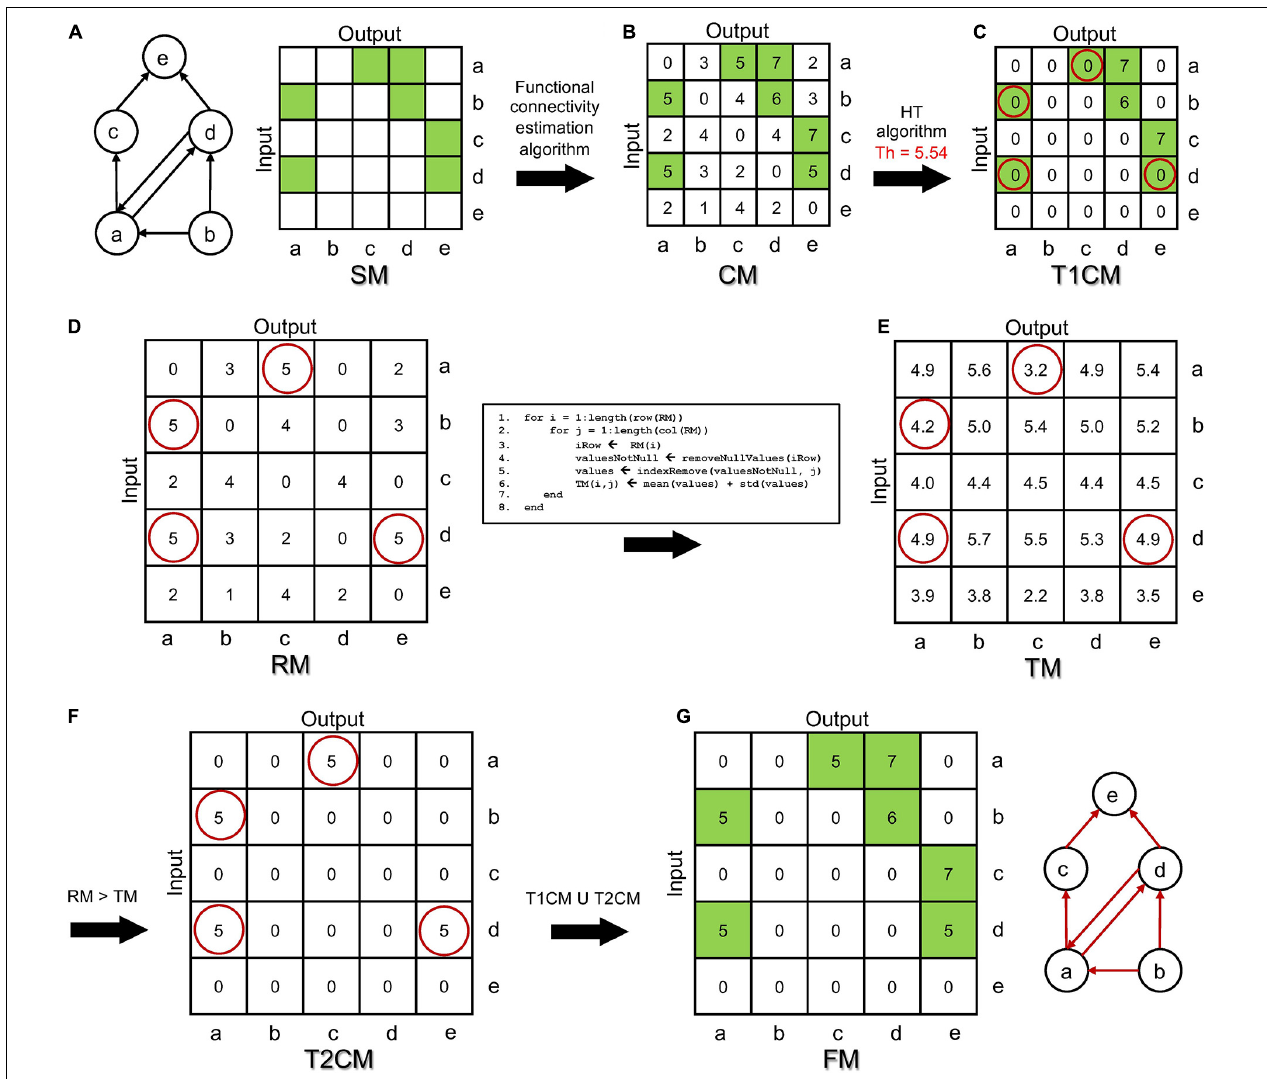
FIGURE 1 | Double Threshold (DDT) algorithm operating principle applied to a simple network. (A) Structural graph made up of n = 5 nodes and the k = 7 structural directed links (left). Structural connectivity matrix (SM) where each green square identifies a structural connection in the graph (right). (B) Functional connectivity matrix (CM) obtained by applying the correlation algorithm to each pair of spike train. In the CM, the green squares show the functional connectivity values that correspond to the actually existing structural links in the network. (C) Applying the first hard threshold ( n = 1), the T1CM matrix was computed. In T1CM, the red circles point to those connections incorrectly deleted from the CM (false negatives). (D) The rejected connectivity matrix (RM) is made of all the values that have been previously deleted by applying the hard threshold to the CM. By applying the stripping process summarized in the pseudo-code, (E) the thresholding matrix (TM) resulting from the application of the second step of DDT to the RM is achieved. It contains the threshold for each corresponding value of T1CM. (F) The T2CM shows every RM value that satisfies the condition RM > TM. (G) Final functional thresholded connectivity matrix (FM) and its relative functional